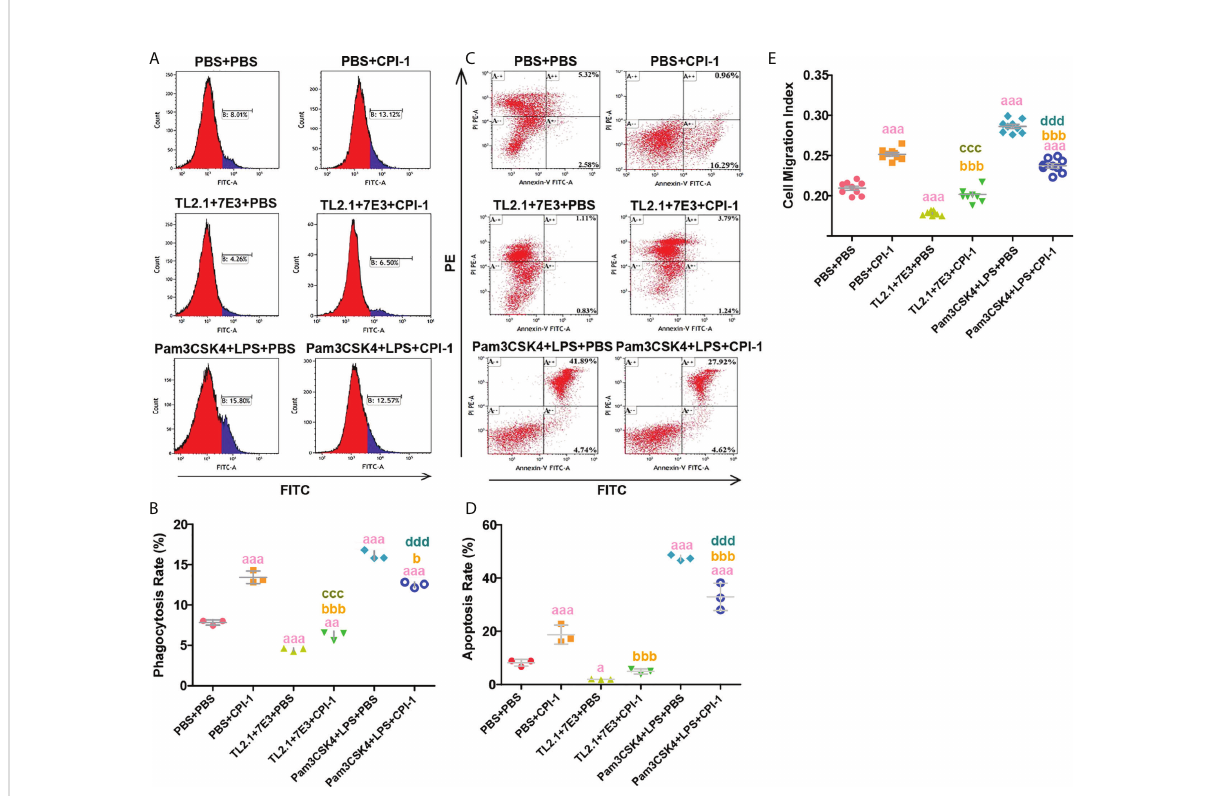
FIGURE 4 Blocking and activation experiments were performed to analyze TLR2/4 directly affecting phagocytosis, apoptosis and migration. (A) Phagocytosis of MDMs was determined by analysis of the phagocytosis of FITC-dextran using FCM. (B) The percentage of FITC+ cells presented is representative of three independent experiments. (C) Apoptosis of MDMs was determined by staining with annexin V and PI using FCM. (D) The total apoptosis rate presented is representative of three independent experiments. (E) Random migration was determined by using a Millicell ® insert with 8.0 µm pores, and the OD 570 values were considered the migration index. The data are shown as the mean ± SD of 3 repetitions per group. a P ≤ 0.05, aa P ≤ 0.01, and aaa P ≤ 0.001 vs. the control group (PBS + PBS); b P ≤ 0.05, bb P ≤ 0.01, and bbb P ≤ 0.001 for the TL2.1 + 7E3 + rBsCPI-1 group or Pam3CSK4 + LPS + rBsCPI-1 group vs. the PBS + rBsCPI-1 group; c P ≤ 0.05, cc P ≤ 0.01, and ccc P ≤ 0.001 for the TL2.1 + 7E3 + rBsCPI-1 group vs. the TL2.1 + 7E3 + PBS group; d P ≤ 0.05, dd P ≤ 0.01, and ddd P ≤ 0.001 for the Pam3CSK4 + LPS + rBsCPI-1 group vs. the Pam3CSK4 + LPS + PBS